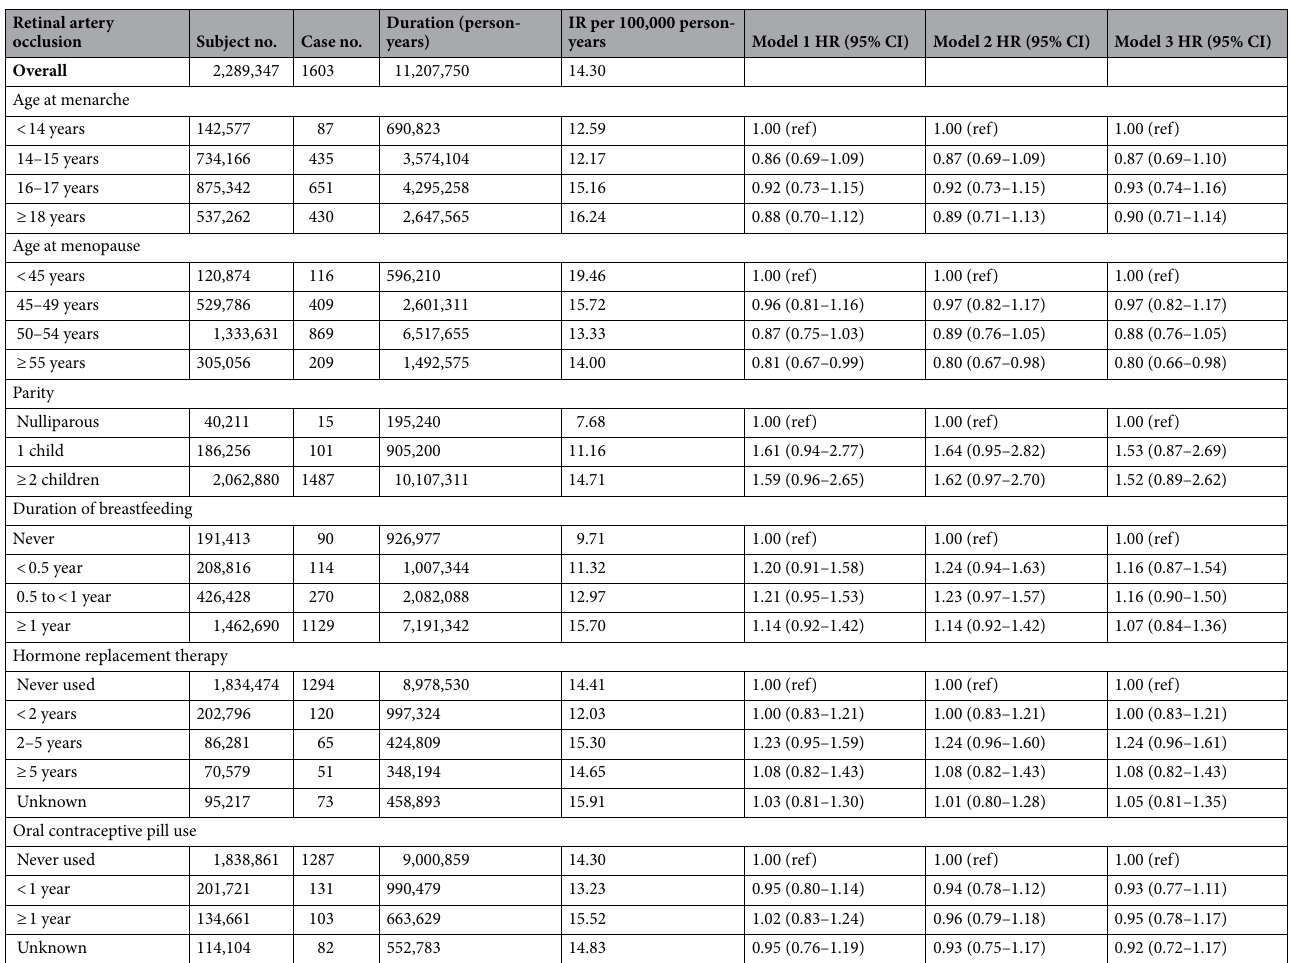
Table 3. Hazard ratios and 95% confidence intervals for development of retinal artery occlusion in postmenopausal women according to female reproductive factors. Model 1: adjusted for age. Model 2: adjusted for age, income level, systemic comorbidities (hypertension, diabetes mellitus, dyslipidemia, stroke, heart disease, and chronic kidney disease), and behavioral factors (smoking history, drinking habit, physical activity, body mass index). Model 3: adjusted for age, income level, systemic comorbidities, behavioral factors, and female reproductive factors (age at menarche, age at menopause, parity, breastfeeding, hormone replacement therapy, oral contraceptive pill). IR, incidence rate; HR, hazard ratio; CI, confidence